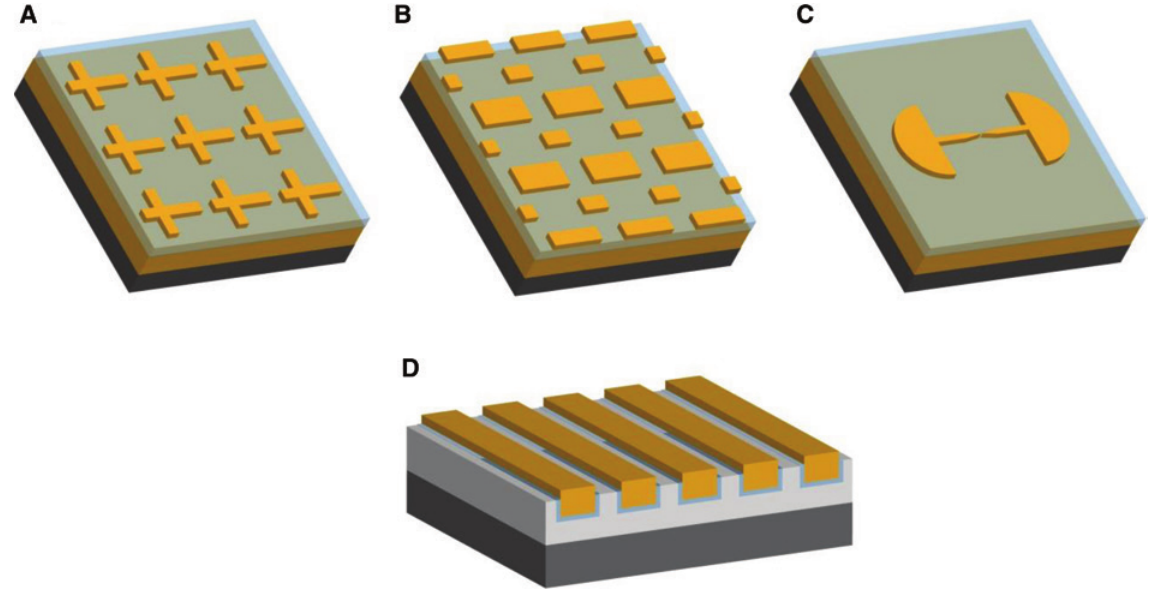
Figure 18: Various perfect absorber designs used for